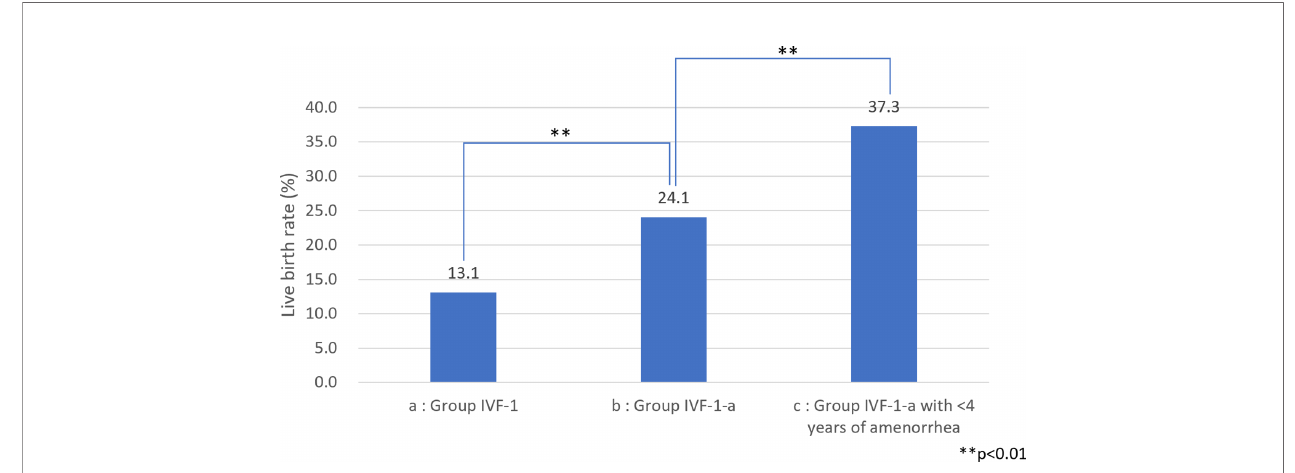
FIGURE 1 | Live birth (LB) rate among patients with idiopathic premature ovarian insuf fi ciency (POI) (A) LB rate among patients with idiopathic POI who underwent ovarian stimulation with human menopausal gonadotropin (hMG)/recombinant follicle-stimulating hormone (recFSH) with GnRH-a under hormone replacement (OS) and in vitro fertilization (IVF-ET). (B) LB rate among patients with idiopathic POI who underwent OS and IVF-ET aged <35 years at the start of follow-up. (C) LB rate among patients with idiopathic POI who underwent OS and IVF-ET aged <35 years at the start of follow-up with <4 years of amenorrhea.